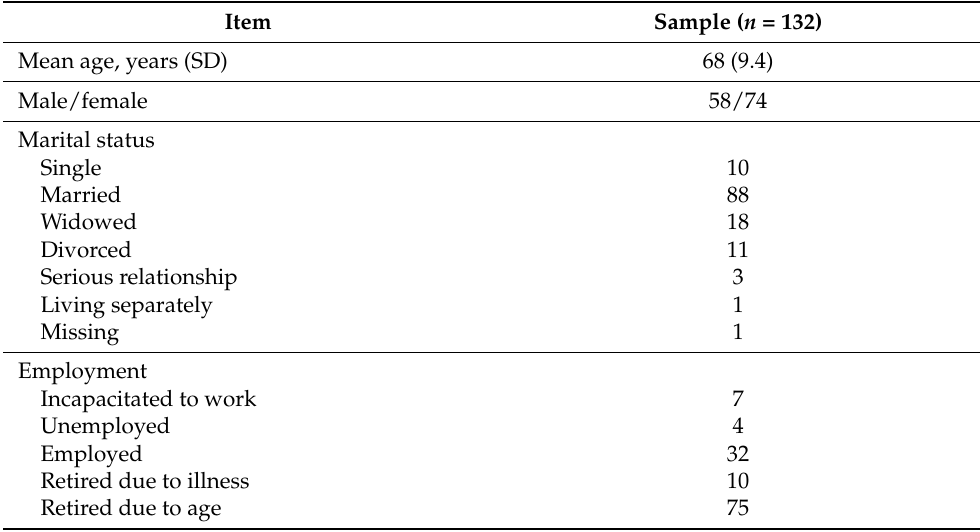
Table 1. Demographic characteristics and baseline characteristics related to age, gender, marital status, and employment